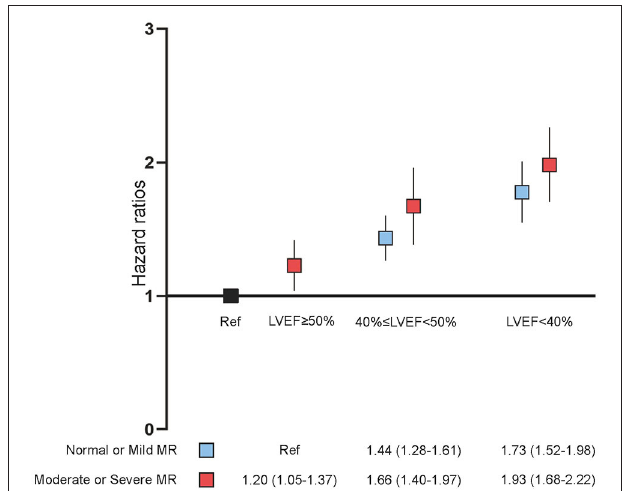
FIGURE 3 | Multivariate Cox proportional analyses. Hazard ratios (HR) for all-cause death (95% CI) adjusted for age, gender, hypertension, diabetes mellitus, acute myocardial infarction, congestive heart failure, chronic kidney diseases, atrial fibrillation (AF), stroke, anemia, percutaneous coronary intervention (PCI), hyperlipidemia, angiotensin-converting enzyme inhibitor/angiotensin receptor blocker (ACEI/ARB), beta-blockers, calcium channel blocker (CCB), statins, antiplatelet, mineralocorticoid receptor antagonist (MRA), loop diuretics, and oral anticoagulants (OAC). MR, mitral regurgitation; LVEF, left ventricular ejection